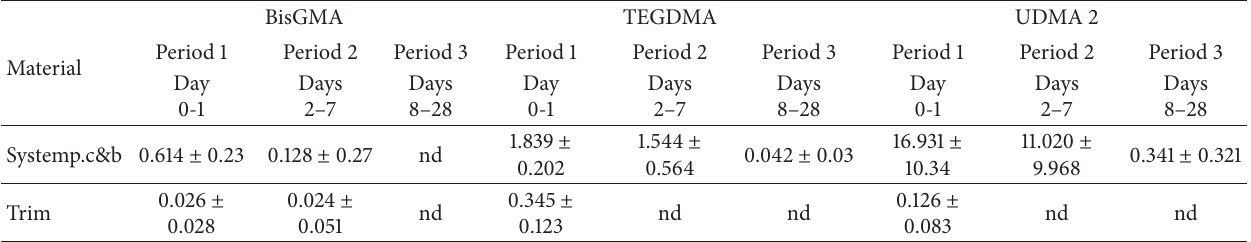
Table 3: Substances released from Systemp.c&b and Trim in ethanol 75% [mean values ( 𝜇 g/mL) ± SD].